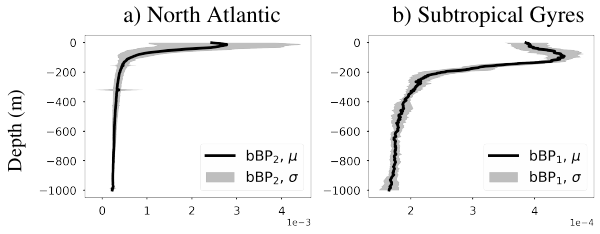
Figure 6. The measured b bp profiles for the validation dataset.